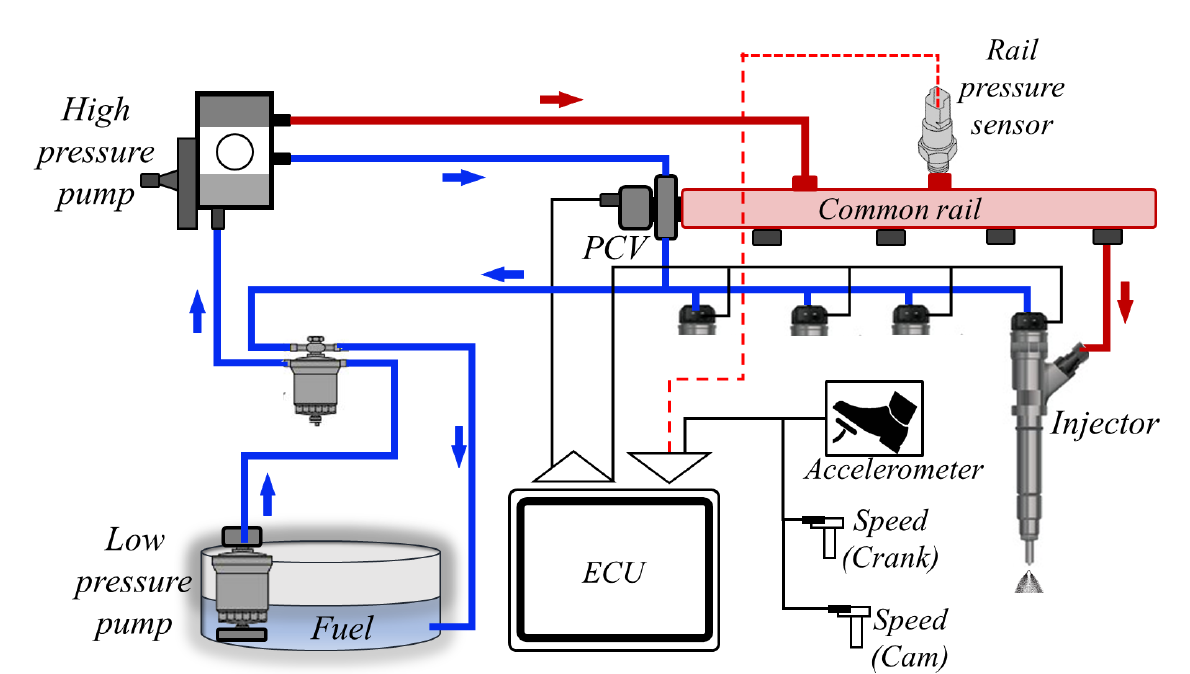
Figure 1. A typical Common rail diesel fuel injection system.